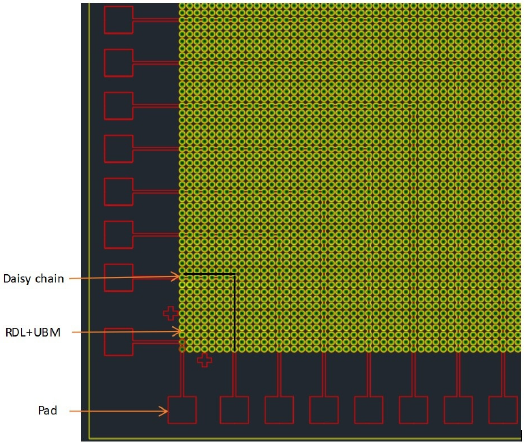
Figure 1. Wafer with pad, bumps and daisy chain partial layout (quarter of die, the green bumps in figure are the superposition of redistribution layer (RDL) and Under Ball Metal (UBM).